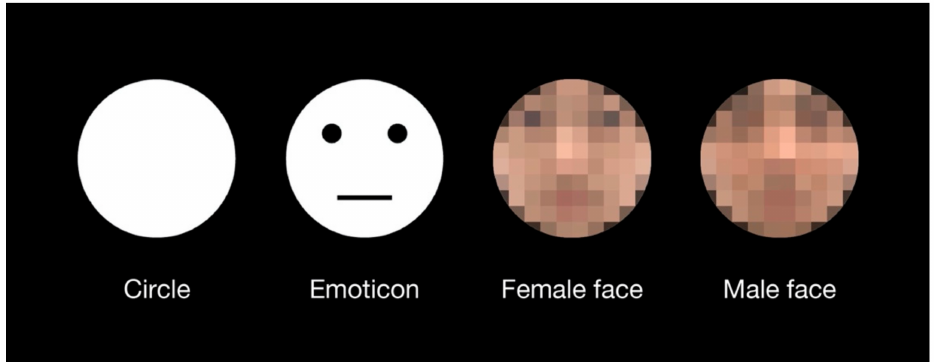
Figure 1. Test stimuli which were used in the experiment. An emoticon with a neutral expression was used because the expressions on the human faces were also neutral. Original images of a female face and a male face without the mosaic were used in the experiment. For this publication, they are presented as a mosaic version due to copyright protection of the facial expression